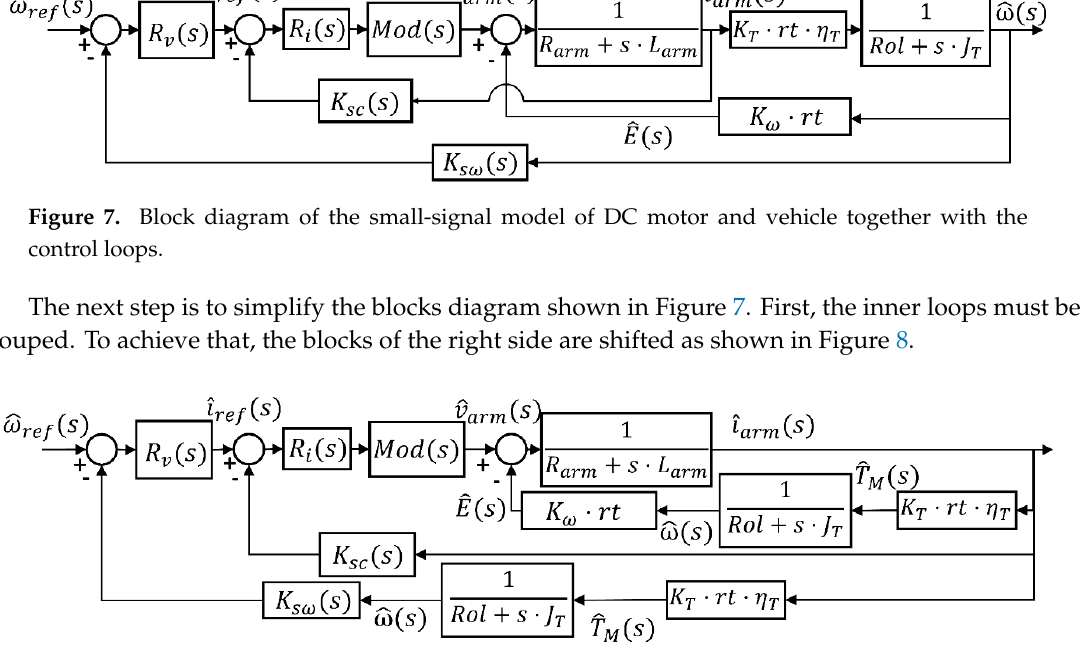
Figure 8. Block diagram of the modified small-signal model.